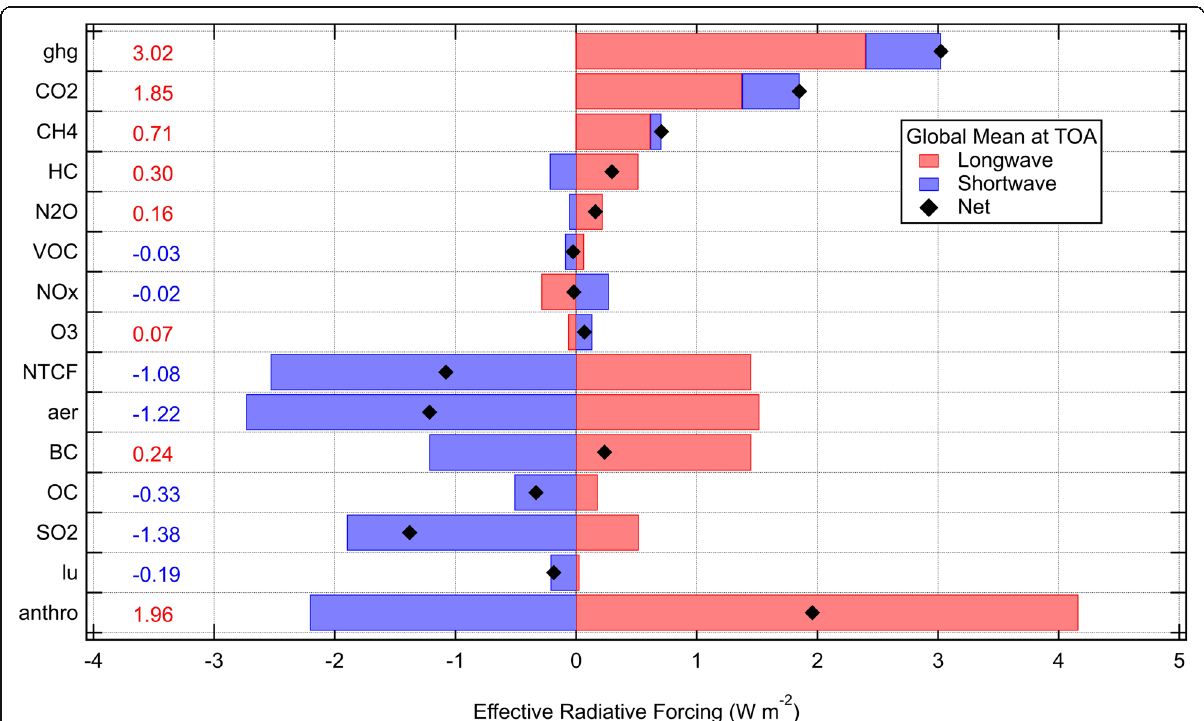
Fig. 2 Global and annual mean ERF estimates at the TOA in each experiment in MRI-ESM2.0. The longwave (red) and shortwave (blue) ERFs and the sum (net, black diamonds) are shown. The net ERF values are also shown on the left side of the figure (positive and negative values are indicated by red and blue, respectively) and are given in units of W m − 2 . The experiment names are shown on the left axis. The ERFs from CO 2 at present-day concentrations are estimated from the piClim-4xCO2 experiment. The ERF values are given in Table